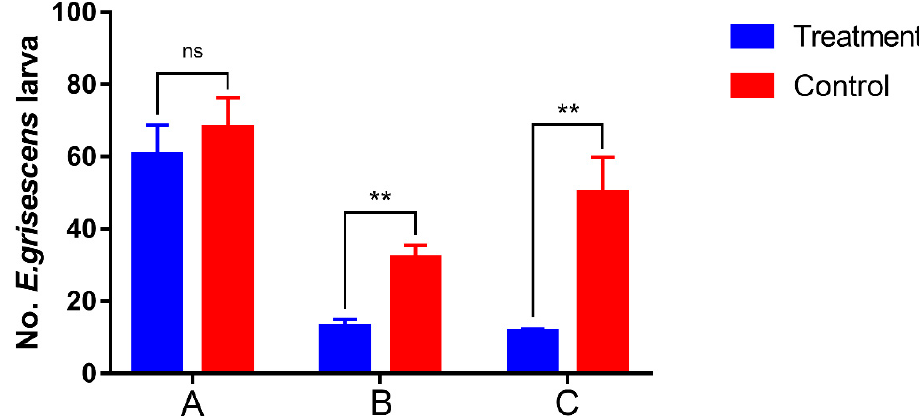
Figure 10. Assessment of larger plot sex pheromone mass trapping trials on population density of Ectropis grisescens larva. ( A ) The number of larva in treated and control plots before mass trapping; ( B ) the number of larva in treated and control plots after trapping one generation of male moths; ( C ) the number of larva in treated and control plots after trapping two generations of male moths. Di ff erent between mass trapping and control plot were analyzed by Student’s t -test, ns means not significant, ** indicating significant statistical di ff erences between the two species at p <